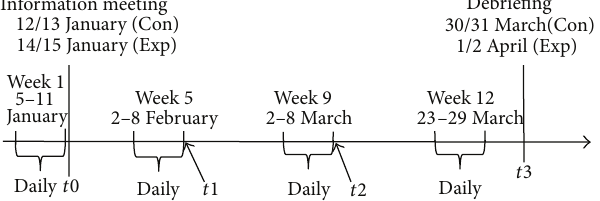
Figure 2: Study timeline. Registration of physical activity every night of weeks 1, 5, 9, and